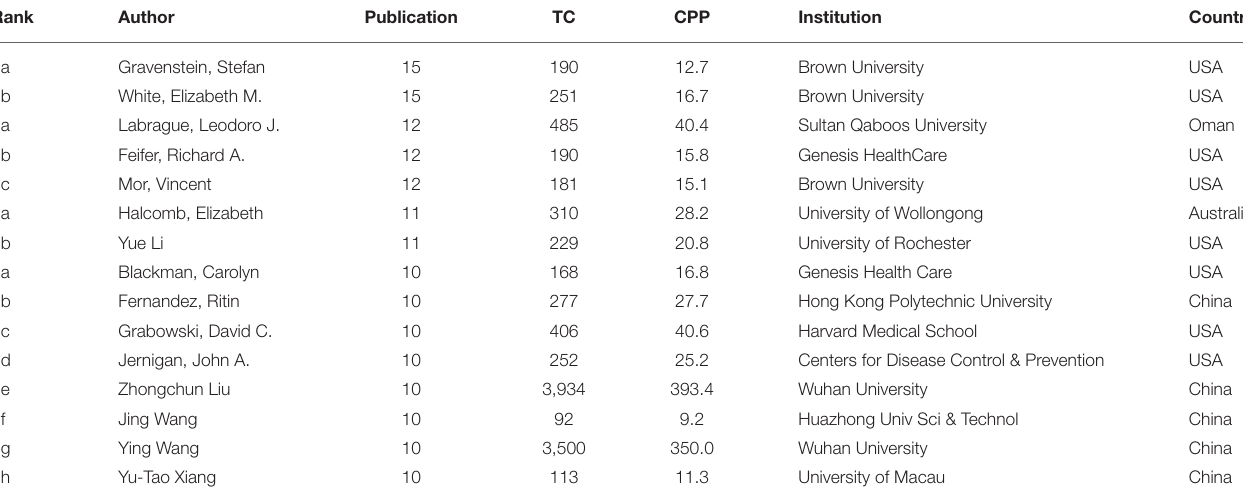
TABLE 1 | Top 15 most prolific